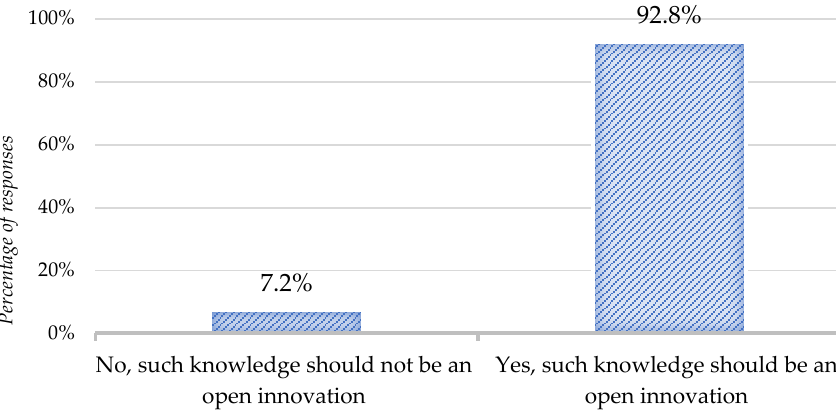
Figure 3. Distribution of answers to the question: ‘ Should the development of methods and tools for stakeholder cooperation be open innovation?’ Source: Own study.